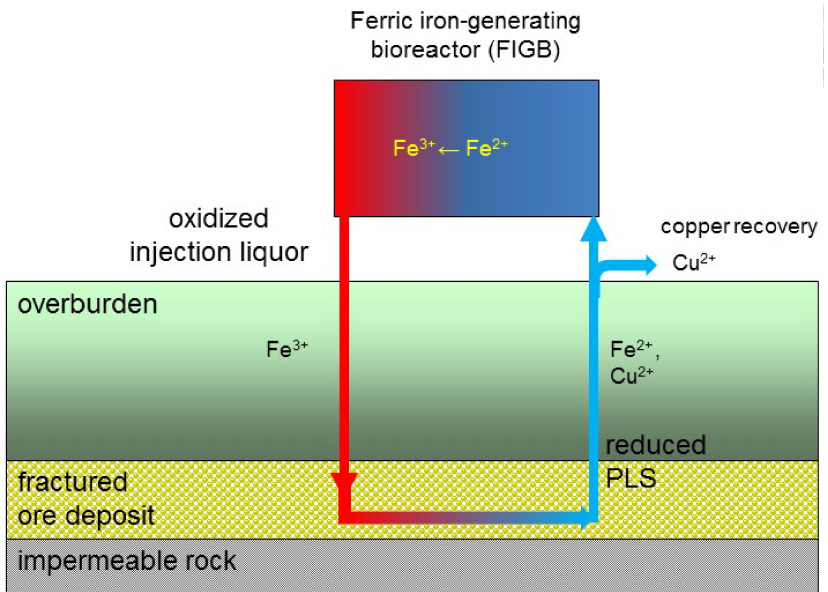
Figure 5. Conceptual configuration of a deep in situ biomining operation to extract copper from an ore body located 1–2 km below the land surface. An oxidised, extremely acidic lixiviant generated in a ferric iron-generating bioreactor located at the surface of the mine is injected to the fractured ore body at a depth where it reacts chemically with metal-containing sulfide minerals, solubilising copper and becoming increasingly reduced. The PLS is pumped back to the surface where copper is stripped and the oxidised lixiviant